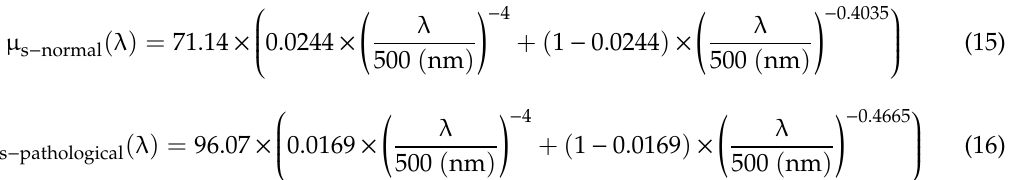
(cid:48) λ ) and µ λ ) for both tissues, we used Equation (1) to calculate s ( s (